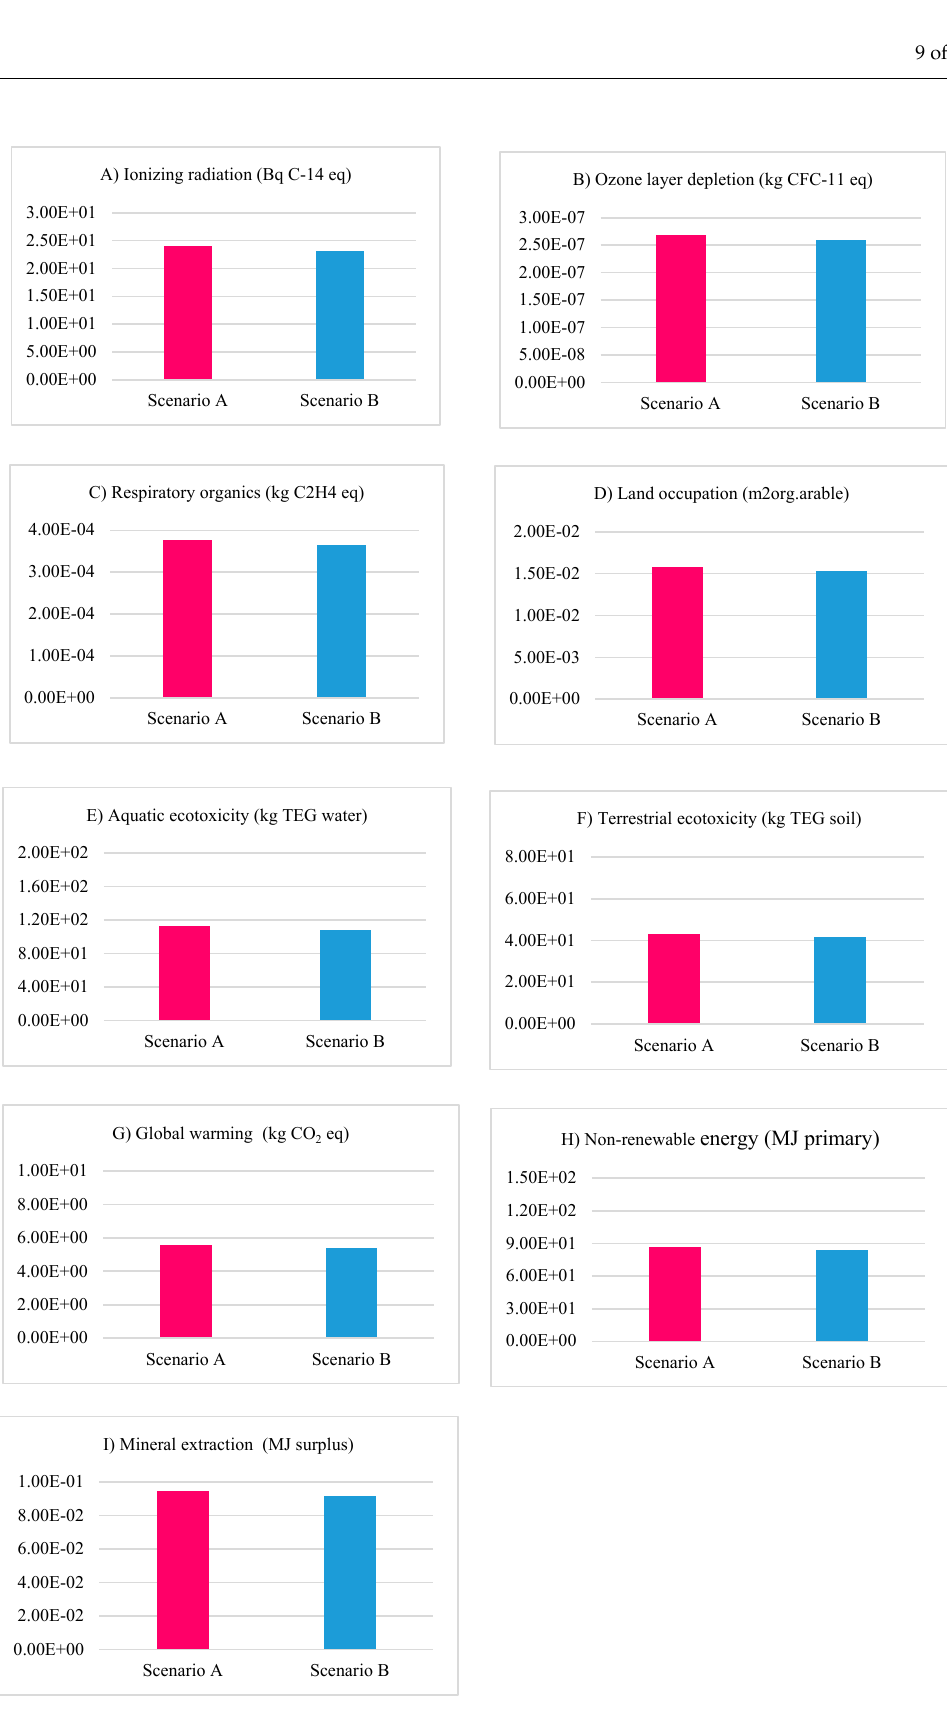
Figure 3. Characterization results under scenarios A and